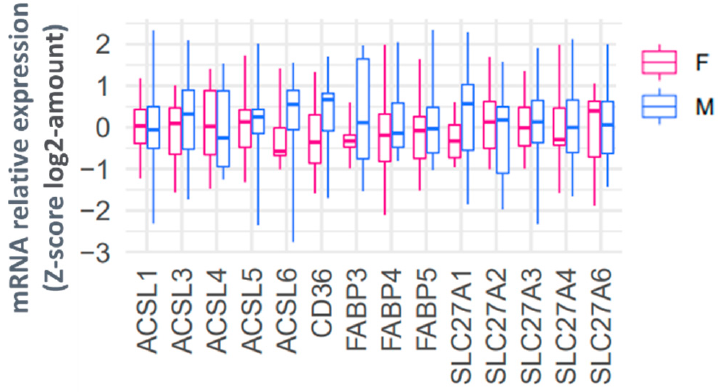
Figure 6. Relative placental mRNA expression of genes involved in fatty acid uptake in females (red) and males (blue). mRNA abundance is normalized to the geometric mean of three housekeeping genes and then log2 transformed and converted to a z-score. Boxes show median and interquartile range while whiskers show minimum and maximum values.